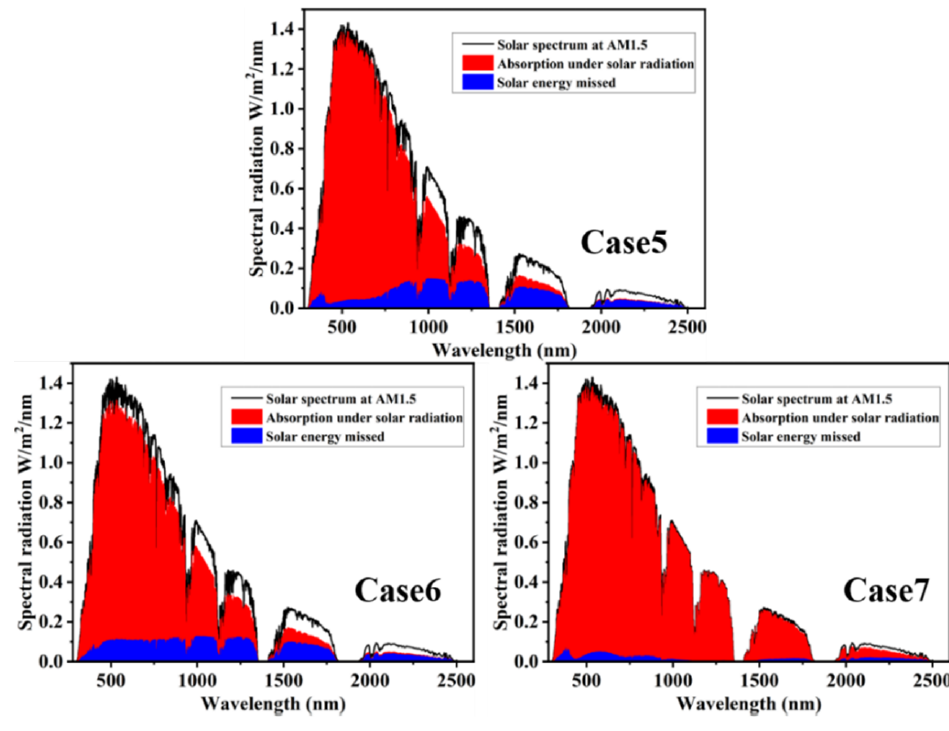
Figure 9. Solar absorption spectral for Case5 to Case7.